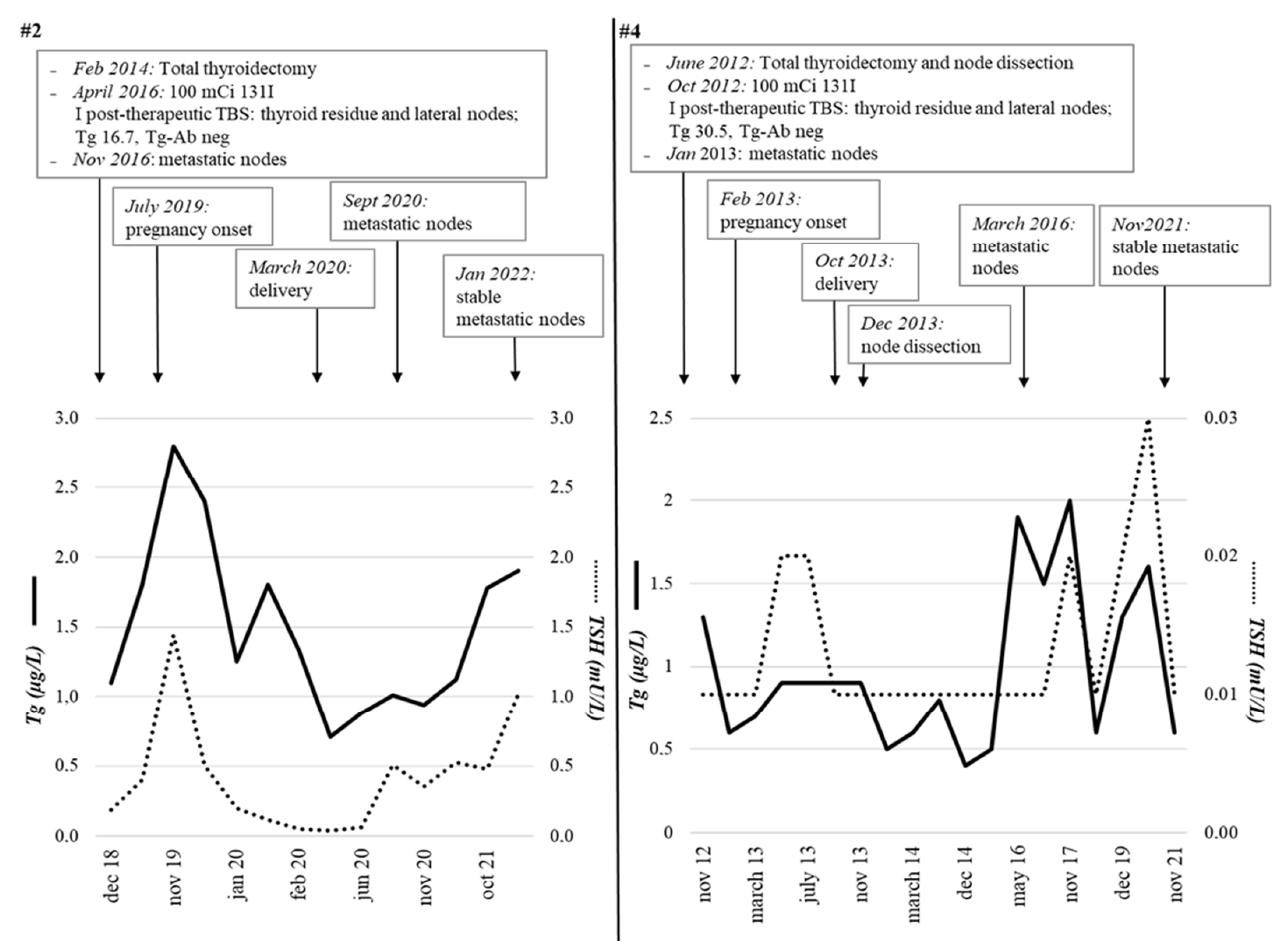
Figure 2. Two representative patients (#2 and #4) with papillary thyroid carcinoma in persistent disease (neck node metastases) at the time of pregnancy onset. The trend of Tg and TSH from the initial treatment (thyroidectomy and radiometabolic therapy) to the last follow-up visit, including pregnancy and postpartum period, is shown. Both patients had negative anti-thyroglobulin auto- antibodies. Both patients had no structural disease progression during or after pregnancy. Tg, Thyroglobulin; TSH, thyroid-stimulating hormone; TBS, Total Body Scintigraphy; mCi, millicurie; RAI, Radioactive iodine.